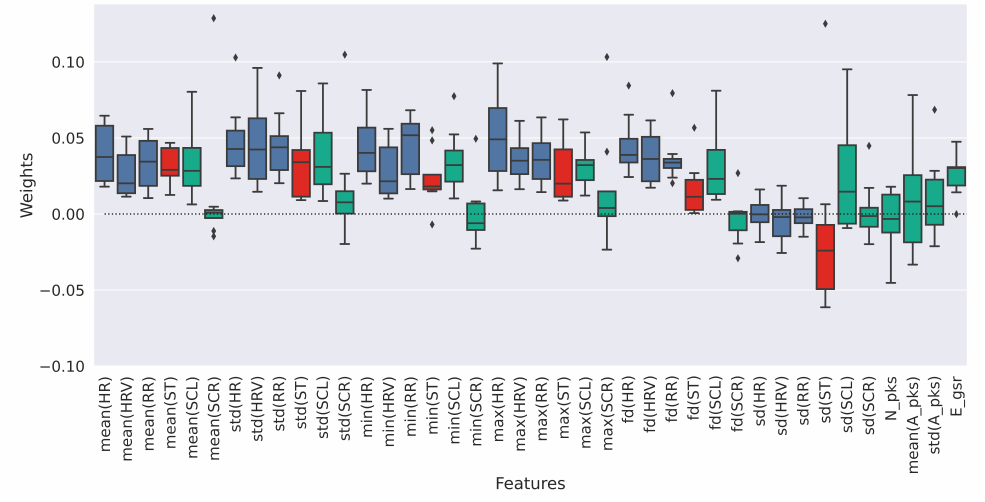
Figure 7. Feature weights computed with the ReliefF algorithm from the PHY dataset of the eight enrolled